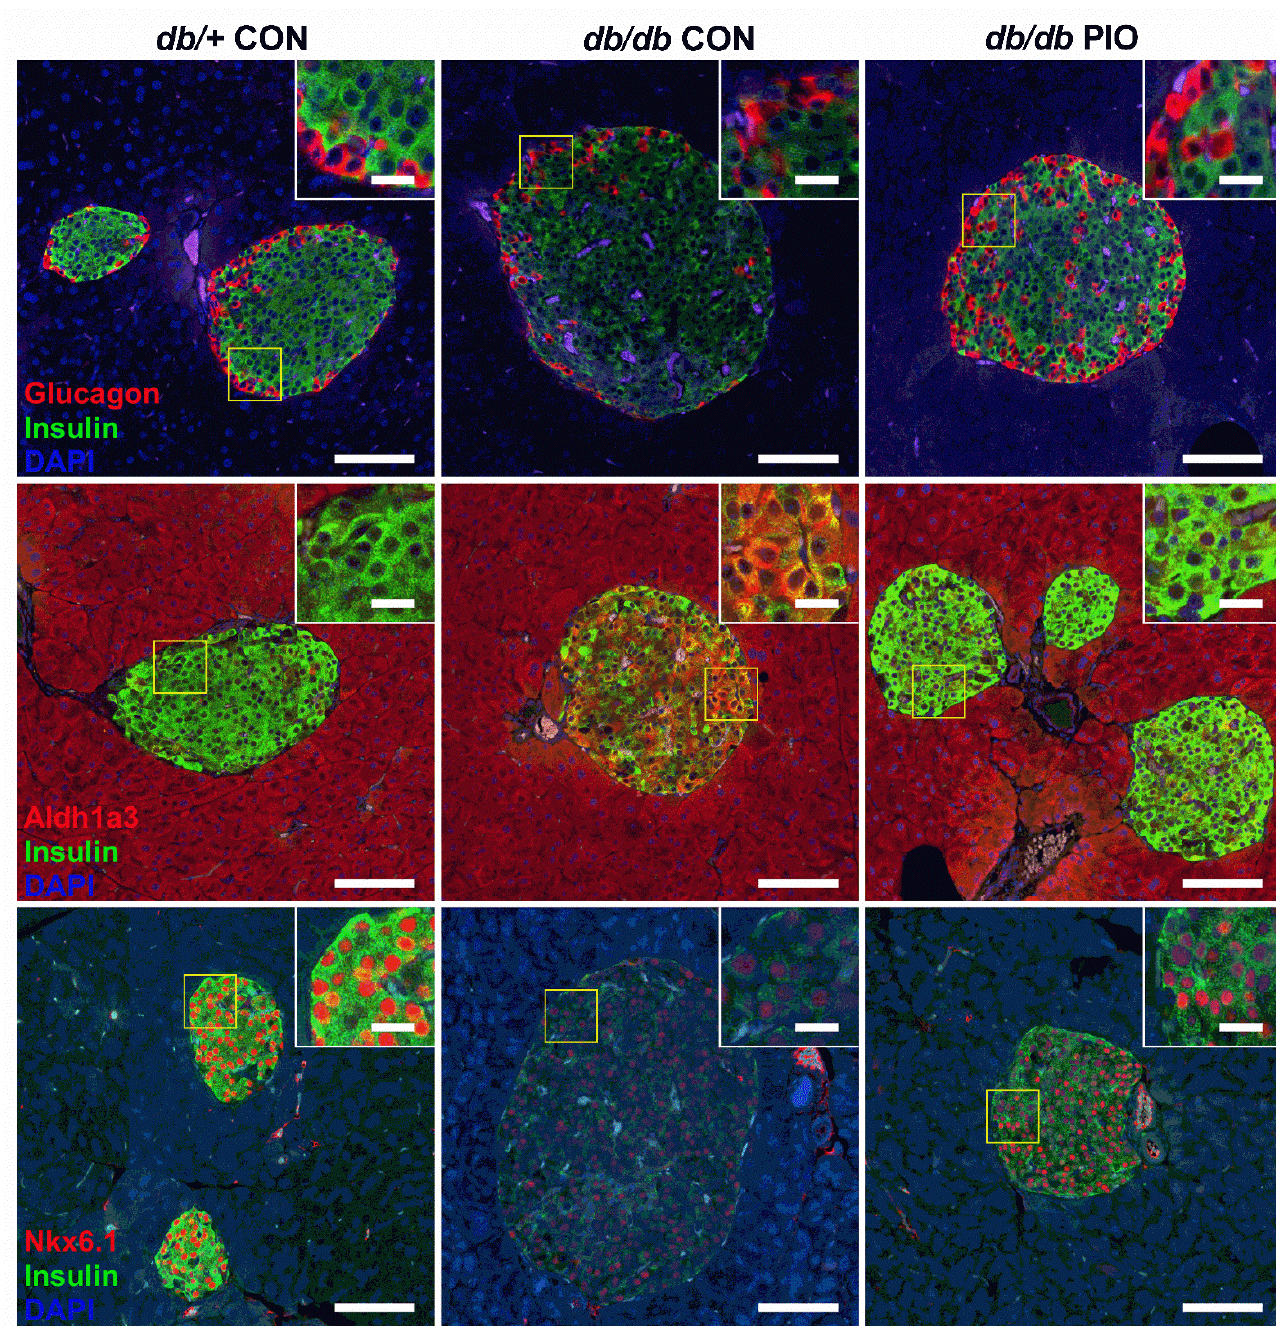
Figure 8. PIO-supplemented diet restores pancreatic Nkx6.1 and decreases abundance of the de-differentiation marker Aldh1a3 in db/db mice. Triple-fluorescence staining of fixed pancreatic tissue from db/+ mice on a control diet (CON), or db/db mice on either a CON or PIO-supplemented diet for 28 d. Insulin staining shown in green and DAPI in blue. The red stain indicates glucagon (top row), Aldh1a3 (middle row), and Nkx6.1 (bottom row). Sections were stained from four animals per group and representative images were chosen from each group. Scale bars = 100 μ m for large image, 20 μ m for inset.